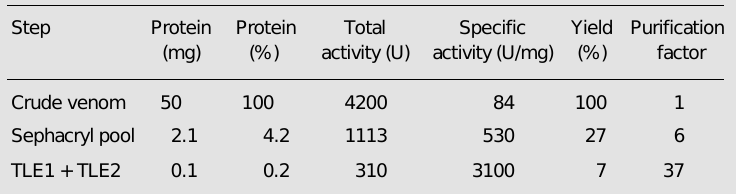
Figure 3 - SDS-polyacrylamide gel electrophoresis of purified thrombin-like enzymes (TLE) from Bothrops atrox venom. Samples were submitted to electrophoresis on 12% slab gel containing 1% SDS. Proteins were denaturated by heating. Lane 1 , 60 µg of crude venom. Lane 2 , 1 µg of TLE1. Lane 3 , 1 µg of